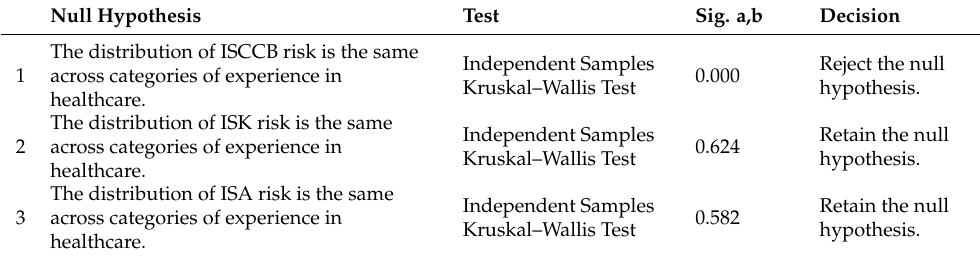
Table 10. Kruskal Wallis non parametric one way ANOVA with work experience and KAB.